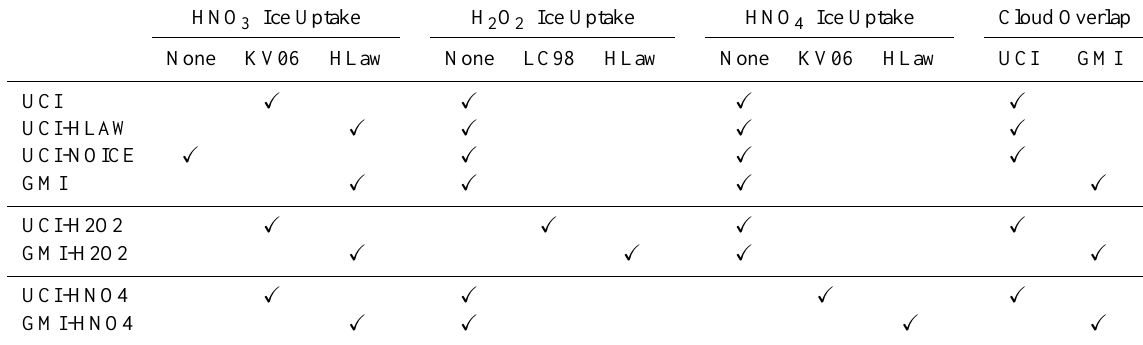
Table 1. Ice uptake and cloud overlap assumptions used for the primary set of simulations described in Sect.